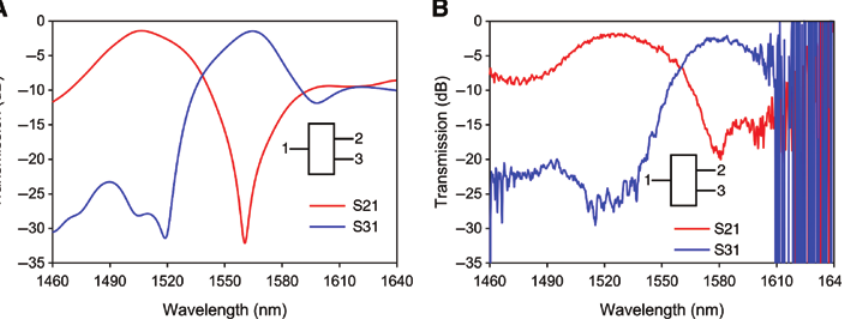
is the transmission from port j to port i . ij